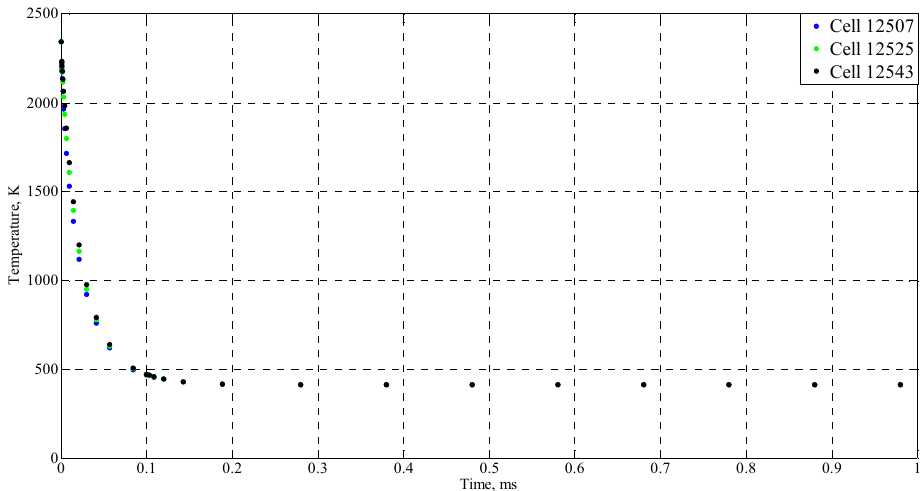
Figure 12. Temperature evolution in the splat cells 12507, 12525 and 12543.